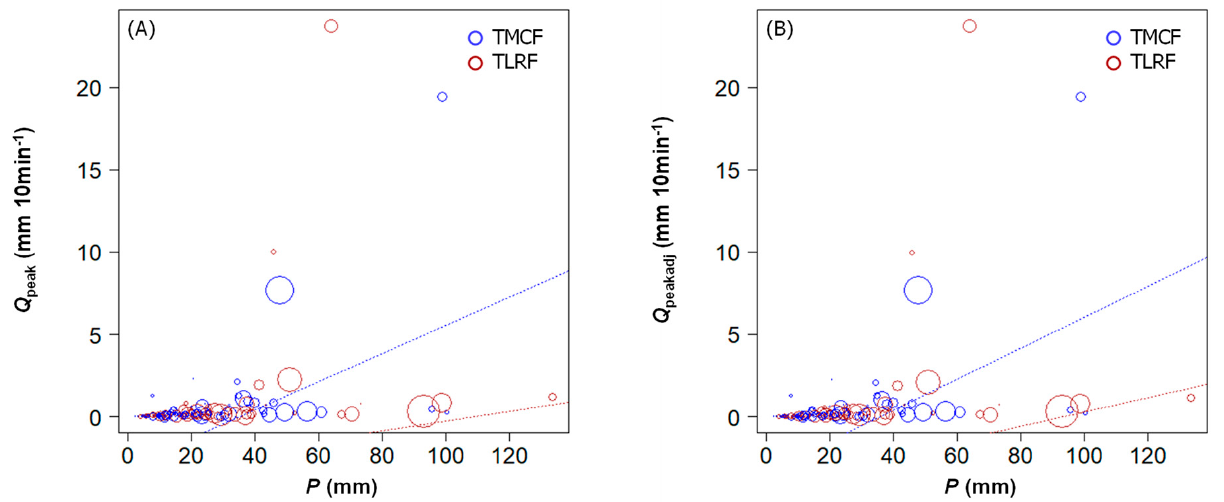
Figure 3. ( A ) Q peak and ( B ) Q peakadj versus event rainfall. Increasing point size corresponds to increasing P i.